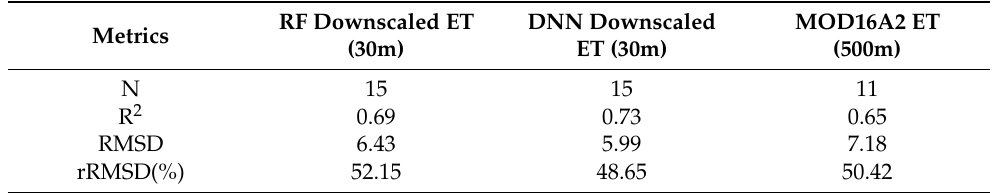
Table 3. Evaluation metrics against three AmeriFlux in situ ET (mm/8-days) for the RF downscaled ET (30 m), DNN downscaled ET (30 m) and MOD16A2 ET (500